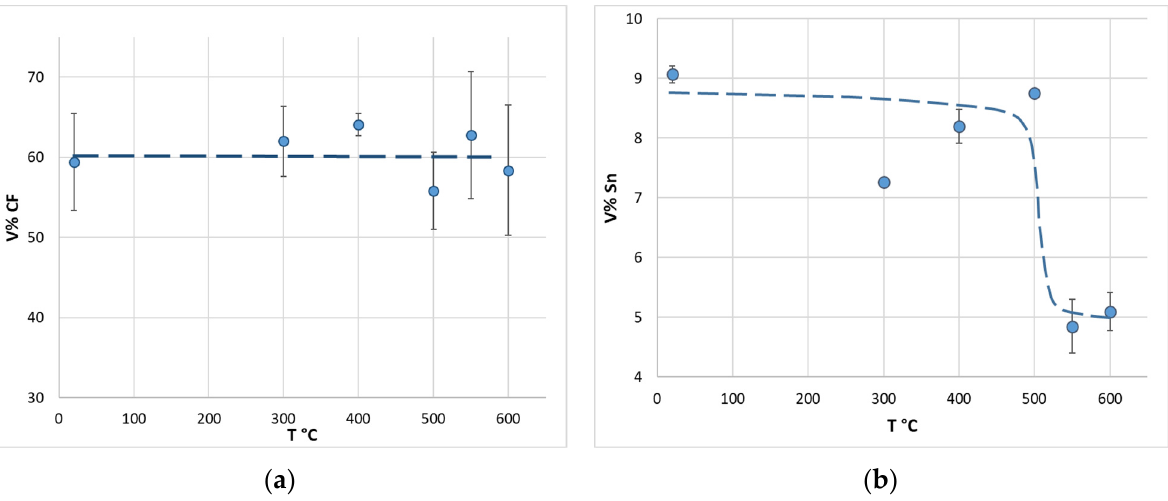
Figure 2. Change in the volume fraction of the carbon fiber ( a ) and the tin structural component ( b ) depending on the heat-treatment